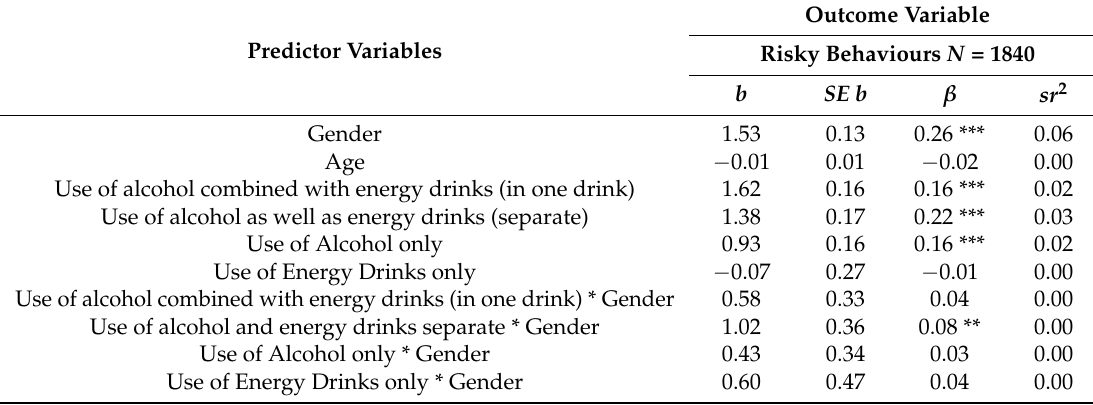
Table 2. Standard multiple regression of predictors on risky